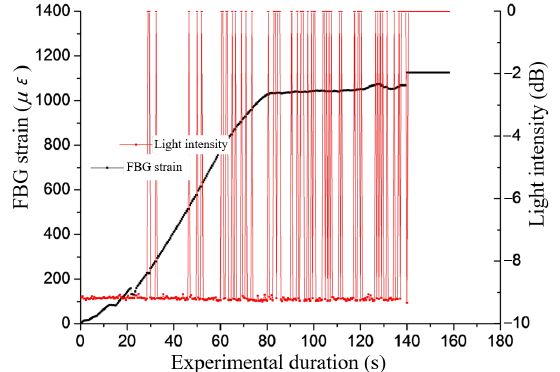
Figure 2. Variation of FBG strain and light intensity with time.